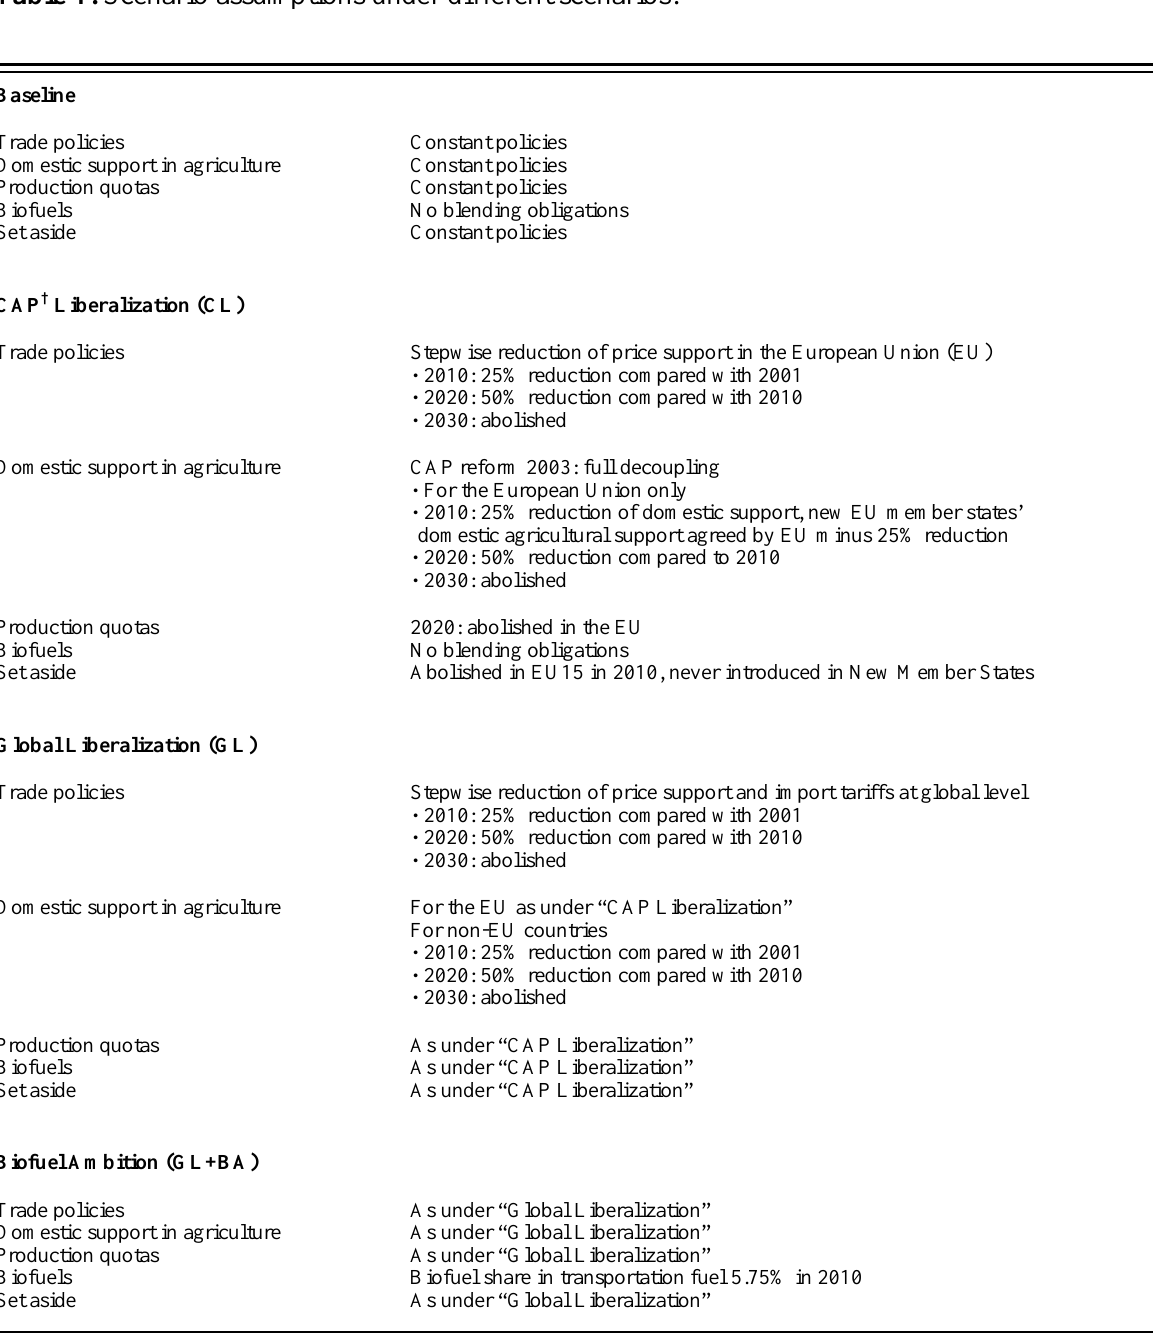
Table 1. Scenario assumptions under different